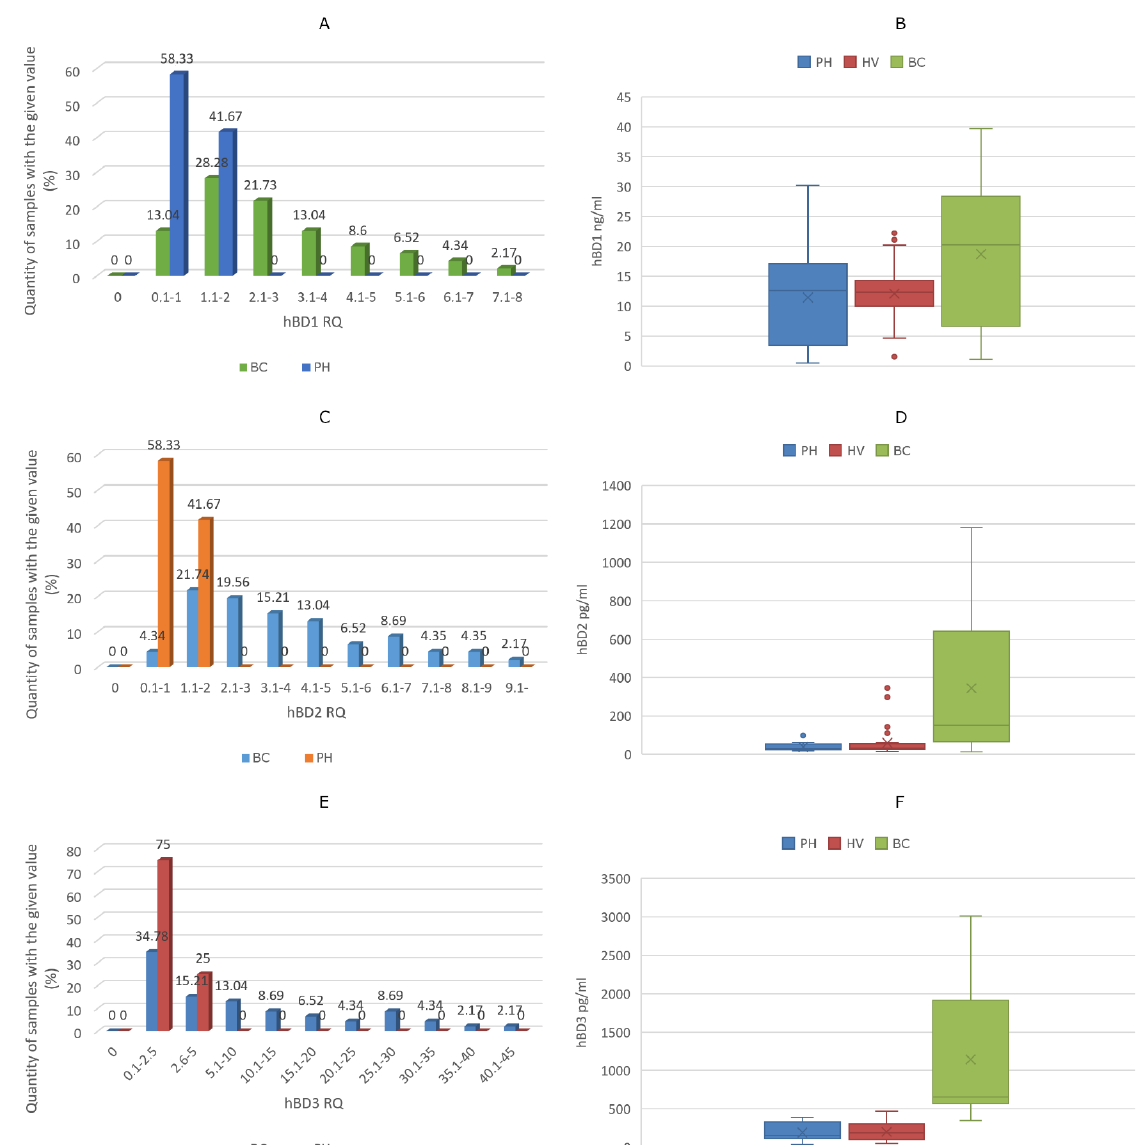
Figure 4 . Defensin mRNA expression RQ values from tissue samples and the amounts of HBDs measured in the urine samples. ( A ) HBD1 RQ in tissue samples, ( B ) HBD1 levels in urine samples, ( C ) HBD2 RQ in tissue samples, ( D ) HBD2 levels in urine samples, ( E ) HBD3 RQ in tissue samples, ( F ) HBD3 levels in urine samples. BC: bladder cancer patients, PH: prostatic hyperplasia patients, HV: healthy volunteers .